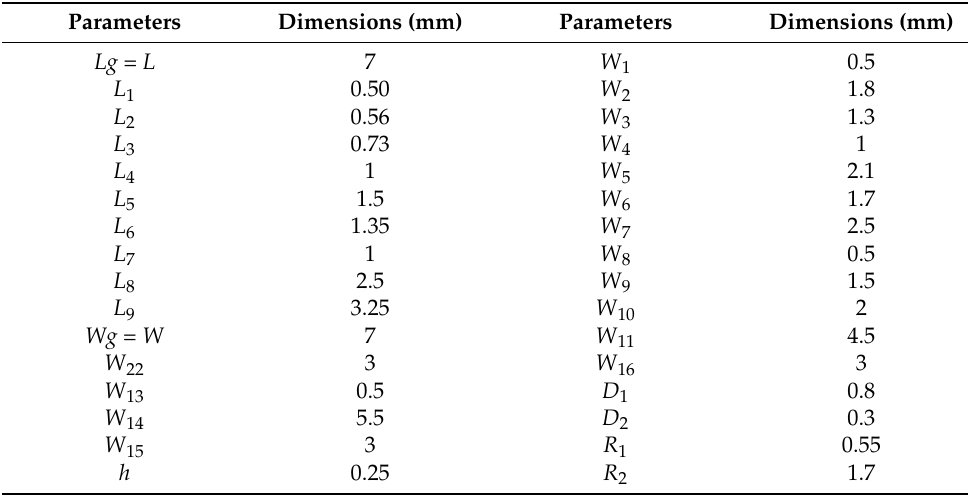
Figure 2. Stated design structure; ( a ) front view, ( b ) back view, and ( c ) 3D view. Table 1. List of the parameters of the stated